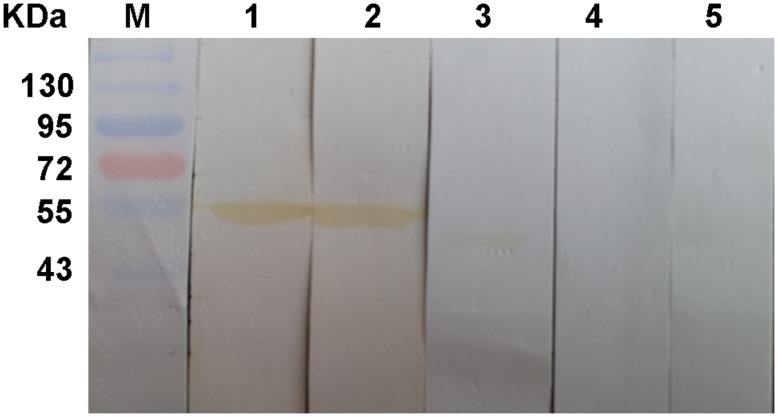
Western blotting analysis of rCsHK.Pre-stained protein markers (lane M), rCsHK reacted with the mouse anti-His tag monoclonal antibody (lane 1), rCsHK probed with the mouse anti-rCsHK serum (lane 2), total worm extract blotted with the mouse anti-rCsHK serum (lane 3), rCsHK probed with the naive mouse serum (lane 4), and total worm extract reacted with the serum from the pre-immune mouse (lane 5).